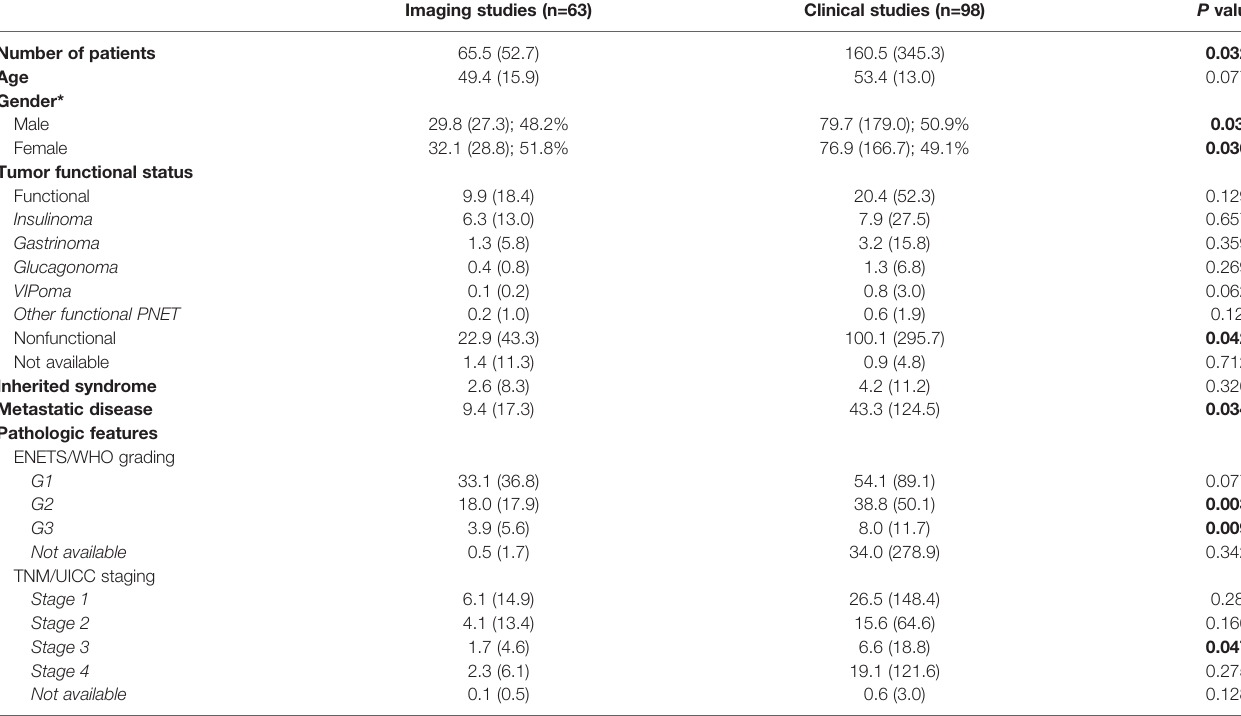
TABLE 3 | Demographic, clinical and pathological variables per